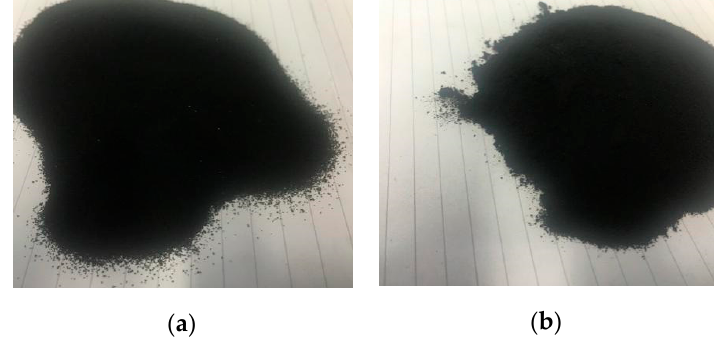
Figure 3. Crumb rubber ( a ) 180-micron; ( b ) 400-micron.